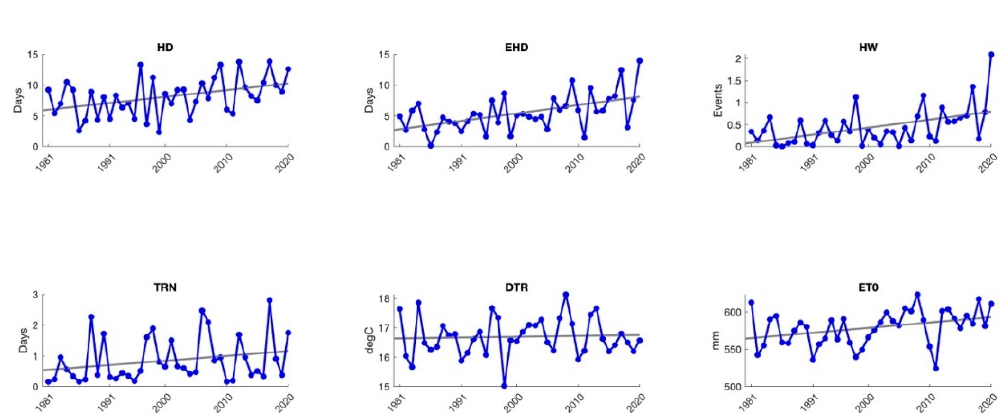
Figure A3. Annual agroclimate metrics averaged over the Salinas Valley region with linear trendline.